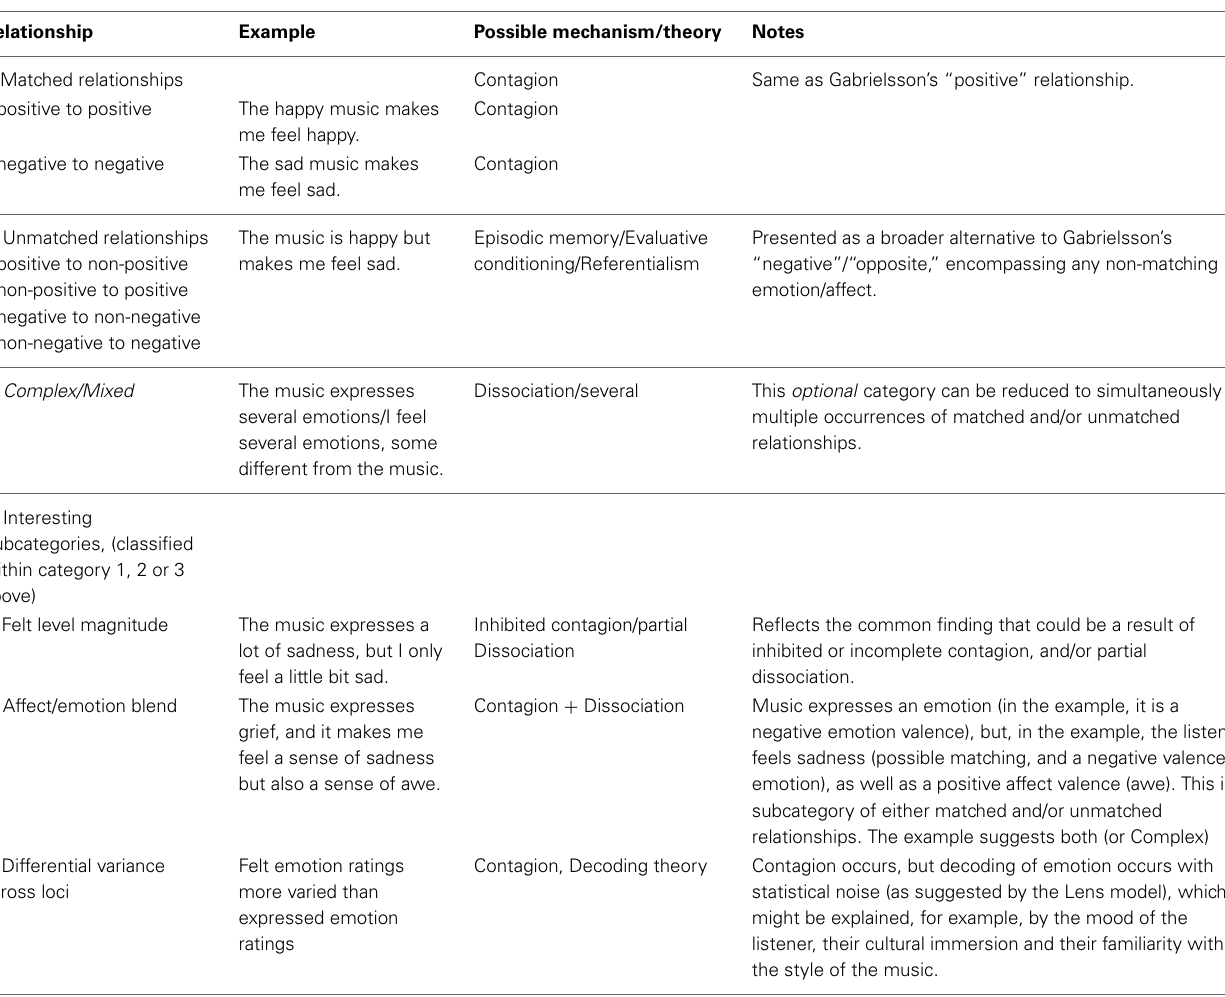
Table 2 | Revision of Gabrielsson’s relationships between felt and expressed emotion loci in